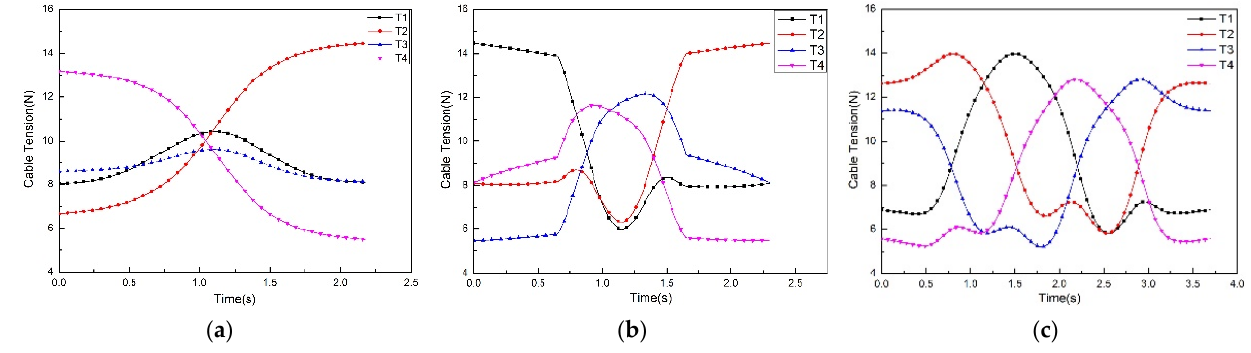
Figure 9. Cable tension–time curve of ( a ) linear motion trajectory, ( b ) parabolic motion trajectory, and ( c ) circular motion trajectory.